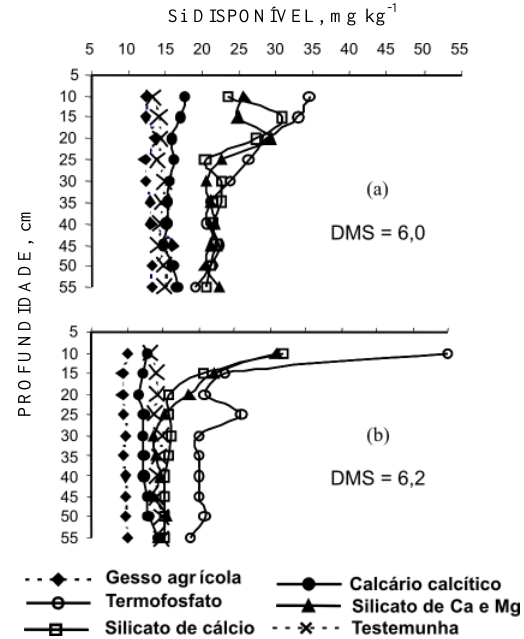
Figura 3. Dinâmica do silício em profundidade, considerando a aplicação de 500 (a) e 1.000 kg ha -1 (b) de cálcio, na forma de corretivos e condicionadores de